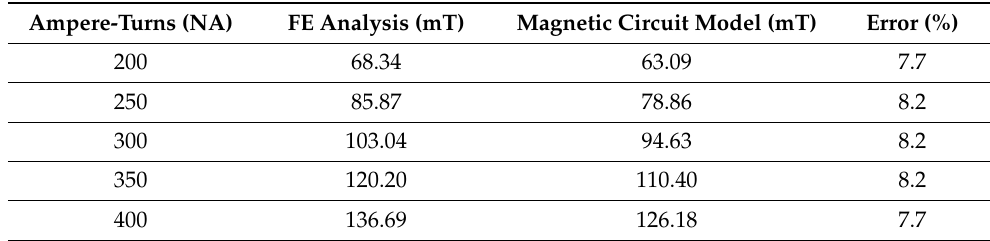
Table 5. The comparison of finite element simulation and modeling calculation results of circumfer- ential